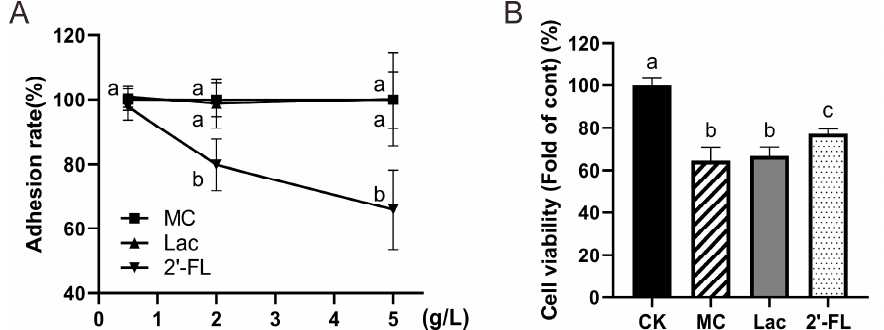
Figure 6. Adhesion rate of E. coli O157 and cell viability under infection. ( A ) Adhesion rates in each group at different concentrations; ( B ) cell viability. Significant differences are indicated by different letters (a–c) ( p < 0.05).